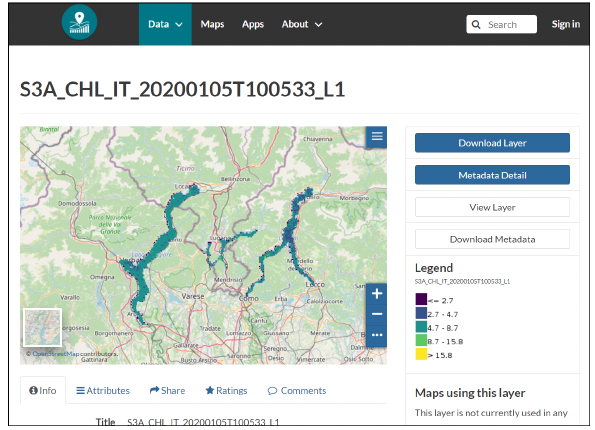
Figure 4: An example of an uploaded WQP product on produc- ers’ application of collaborative platform